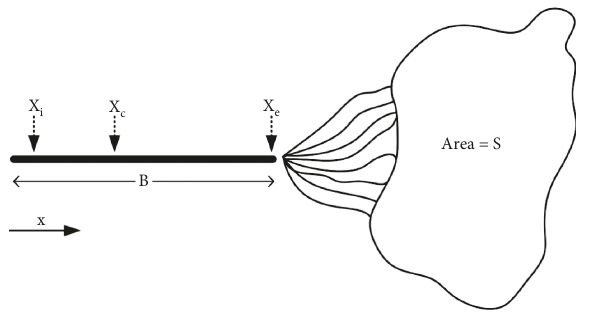
Figure 2: Schematic of the service area and the corridor.